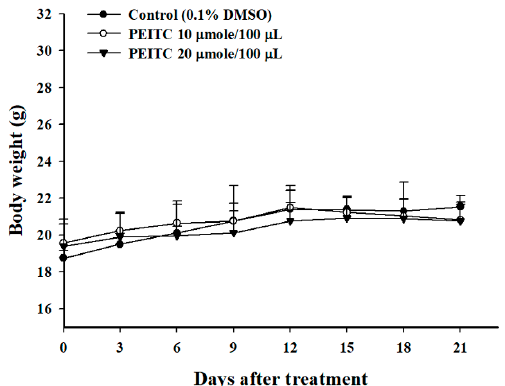
Figure 1. The effects on body weight in xenograft GBM 8401/ luc2 cells-bearing mouse models. The body weights of mice treated with phenethyl isothiocyanate (PEITC) remained similar to those of control mice throughout the study period.